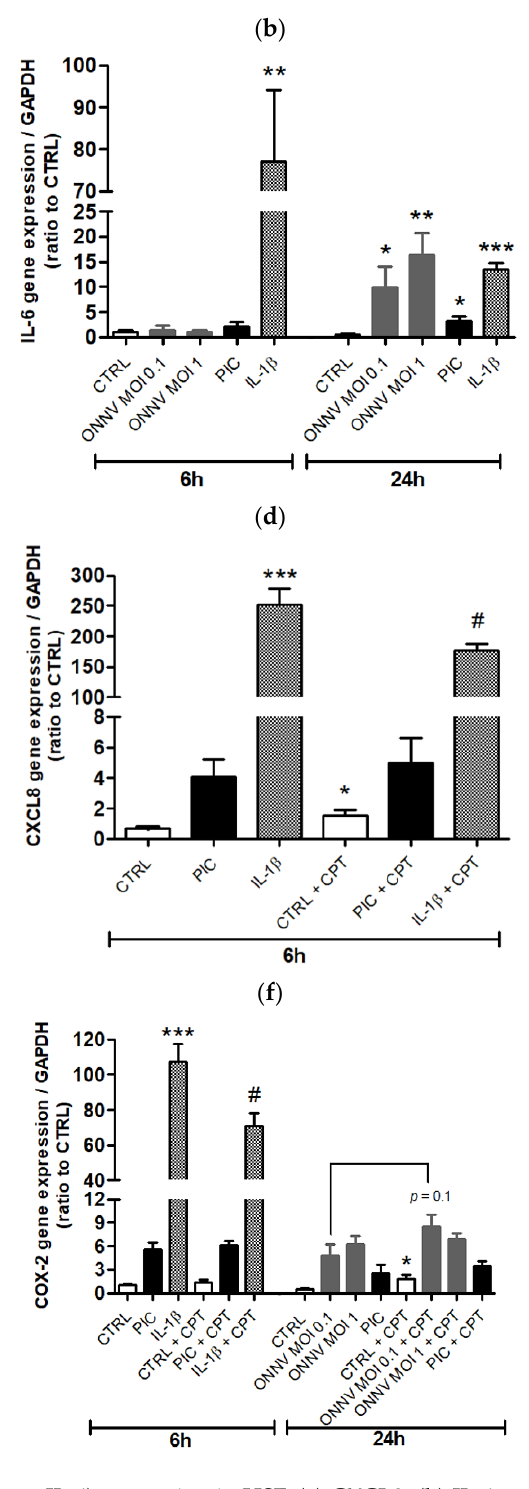
Figure 4. CPT-11 reduces IL-1 β -induced CXCL8 and COX-2 (but not IL-6) expression in HSF. ( a ) CXCL8, ( b ) IL-6 and ( c ) COX-2 mRNA levels from HSF treated with ONNV, PIC and IL-1 β , for 6 and 24 h, were evaluated by RT-qPCR. ( d ) CXCL8, ( e ) IL-6 and ( f ) COX-2 mRNA levels were next assessed in HSF treated in the presence of CPT-11. Results are expressed as mean ± SEM of four independent experiments. Statistical significance is indicated as follows: p -value < 0.05 (*), p -value < 0.01 (**), p -value < 0.001 (***) compared to control at the corresponding time of treatment; p -value < 0.05 (#) compared to the corresponding treatment without CPT-11 .